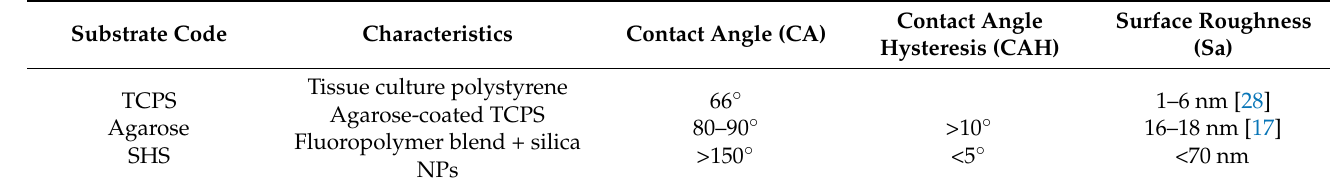
Table 1. Surface characteristics of the substrates. Substrate Code